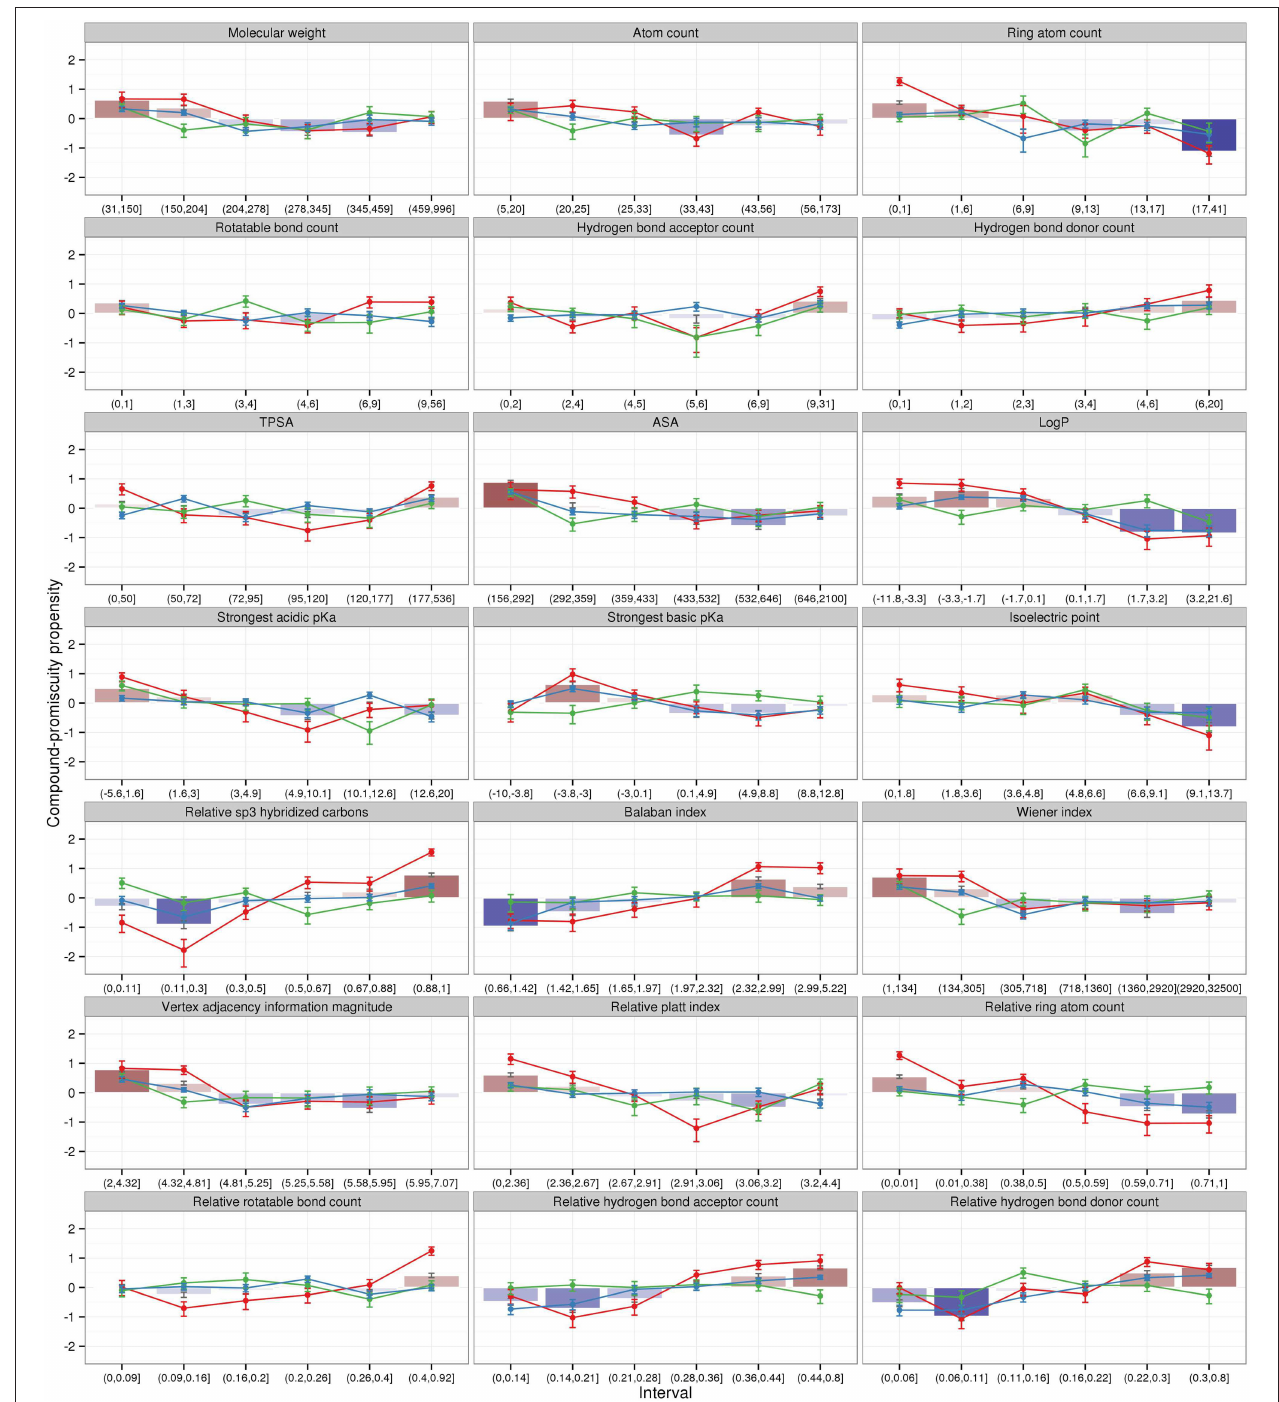
FIGURE 2 | Logarithmic promiscuity propensity ratios of all compounds (bars) and individual compound classes (lines) for diverse physicochemical properties. Positive propensity values (red color gradient) denote that a given property interval is characteristic for promiscuous compounds. Negative values (blue color gradient) show that a property interval is biased in favor of selective compounds, which have only one or two target pockets. Differently colored lines and associated error bars correspond to drugs (red), metabolites (green), and overlapping compounds (blue). Error bars denote the estimated standard error of the mean